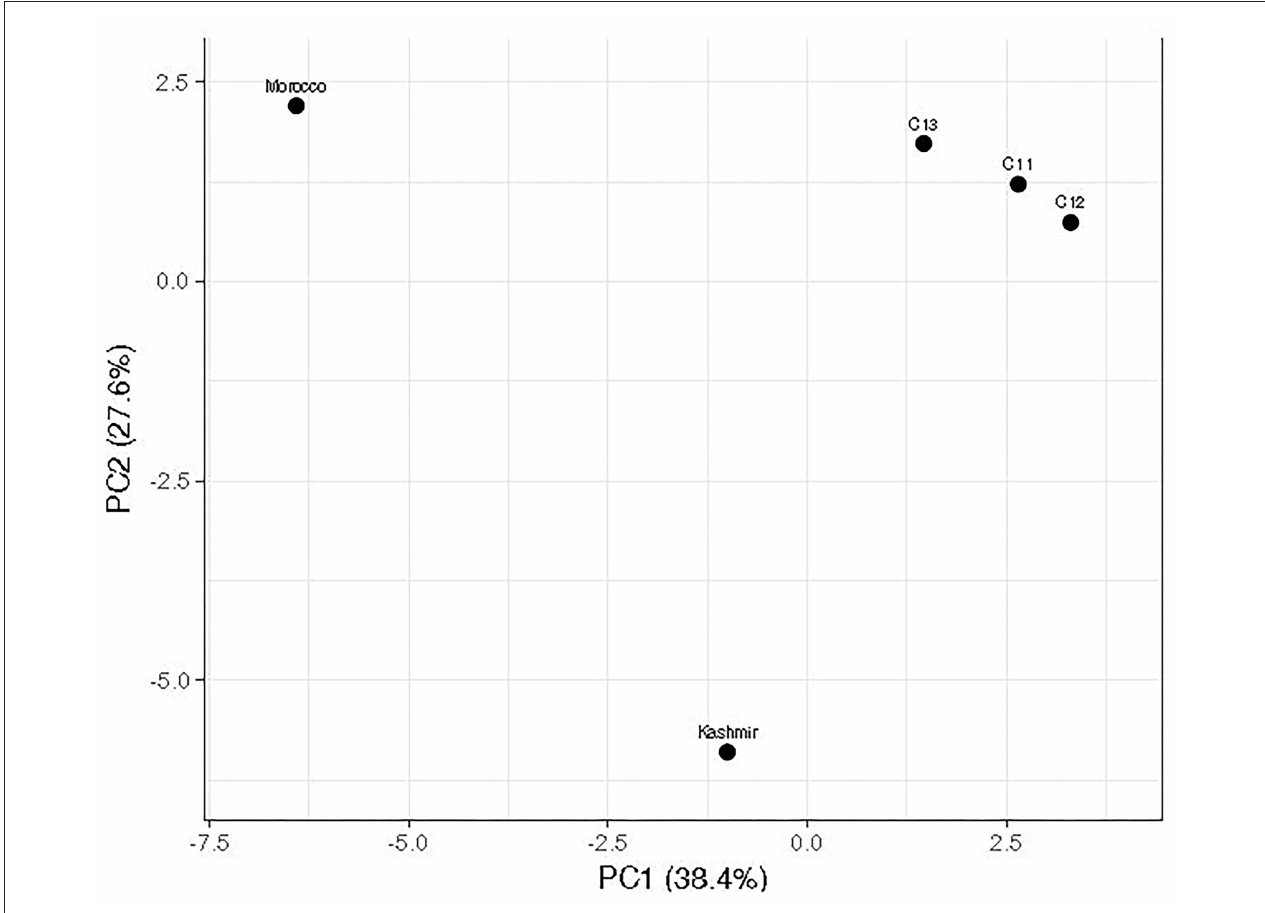
FIGURE 11 | Comparison of microbial diversity of Kishtwar during three consecutive year’s sample (C11, C12, and C13) with Kashmir and Morocco. It represents that Kashmir and Morocco are significantly different from the rest of the sample as it does not cluster with Kishtwar